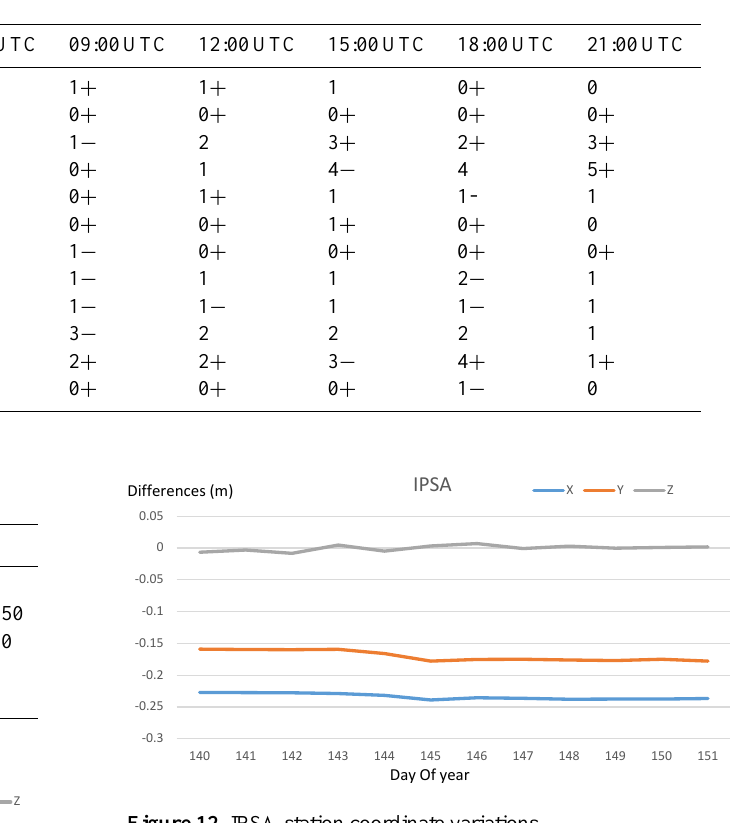
Table 6. K p index values for analysed days.